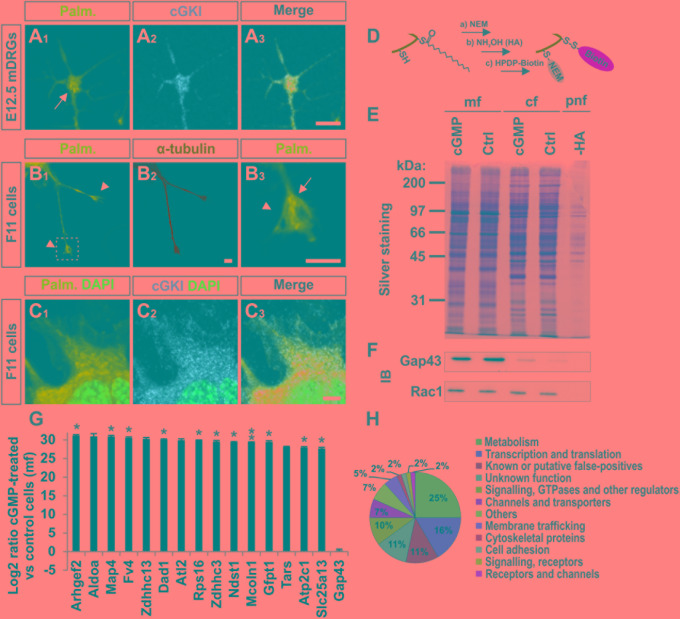
cGKI colocalizes with palmitoylated intracellular proteins in growth cones and 8-pCPT-cGMP-induced signaling stimulates S-palmitoylation of a restricted set of proteins. (A1–A3) Visualization of palmitoylated proteins by metabolic incorporation of a palmitate analog into proteins and by click chemistry in cultures of dissociated DRGs from E12.5 embryos followed by anti-cGKI staining. Palmitoylated proteins are present primarily in the C-domain (arrow) which overlaps with cGKI. Scale bar, 5 μm. (B1–B3) Visualization of palmitoylated proteins by the same approach in the center (arrow) of neurite-like protrusions (arrowheads) of F11 cells. For comparison the localization of α-tubulin is shown. The square in (B1) depicts the region enlarged in (B3). Scale bar, 5 μm. (C1–C3) Visualization of palmitoylated proteins and localization of cGKI in the soma of F11 cells. Scale bar, 5 μm. (D–H) Purification of palmitoylated proteins upon 8-pCPT-cGMP stimulation by ABE chemistry. (D) Illustration of the labeling procedure of palmitoylated proteins by the ABE chemistry approach (Step a: thiol blockade with NEM, step b: thioesther bound cleavage with hydroxylamine (HA), step c: biotinylation of free thiols with HPDP-biotin moiety). (E) SDS-PAGE of palmitoylated proteins from F11 cells stimulated or non-stimulated (Ctrl) by 8-pCPT-cGMP (1 mM, 10 min). The post-nuclear fraction containing membrane and cytosolic proteins was used as control for the labeling procedure by omitting hydroxylamine (-HA). Molecular mass markers are indicated at the left of the panel. mf, crude membrane fraction; cf, cytosolic fraction; pnf, post-nuclear fraction. (F) Western blotting using anti-GAP43 and anti-Rac1 – two known palmitoylated proteins which were not enriched in the 8-pCPT-cGMP-stimulated fractions (Gap43 served as a positive control for the crude membrane fraction and rac1 for both cytosolic and membrane fractions). Note that no signal was detected in the sample without HA treatment revealing the specificity of the purification of S-palmitoylated proteins. (G) S-Palmitoylation of 15 proteins was increased upon cGMP stimulation in F11 cells in three independent experiments. Label-free LC-MS was used for quantification. Data are shown as log2 of the ratio between cGMP treated and untreated samples from the crude membrane fractions. 1 was given to control when it was equal to zero. Note that no change of S-palmitoylation for Gap43 upon cGMP stimulation was measured corroborating the Western blotting results in (F). p < 0.05 (∗), p < 0.001 (∗∗). (H) Classification of proteins that were palmitoylated upon 8-pCPT-cGMP stimulation in 3 and 2 independent experiments (in total 60 proteins).